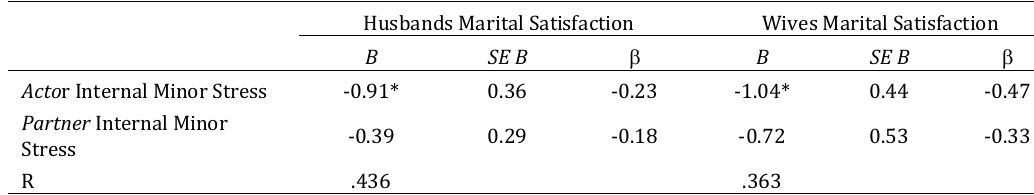
Table 2 Actor-partner interdependence model